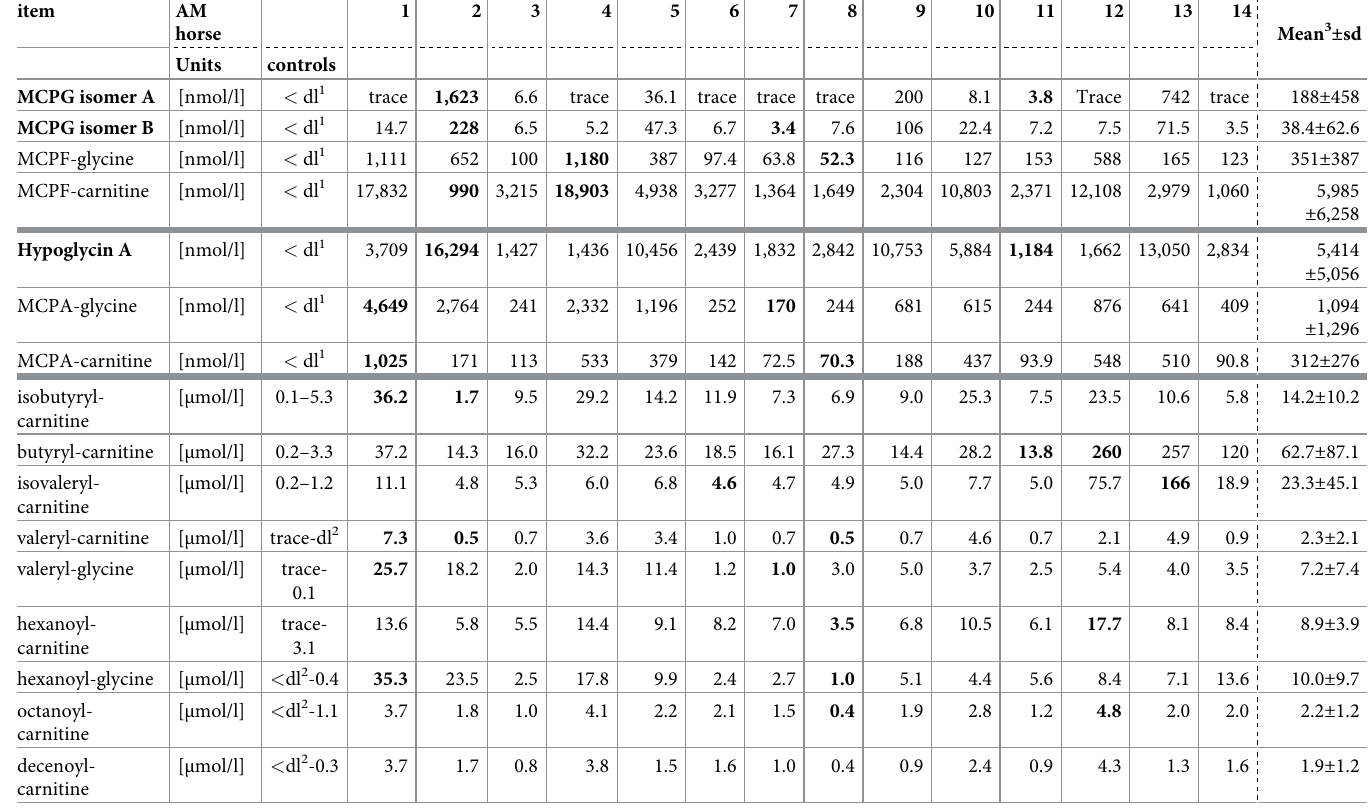
Table 3. Concentrations and means ± sd of MCPG and HGA and the corresponding metabolites in nmol/L plus the concentrations of a spectrum of acyl conjugates in μ mol/L in the serum samples of AM affected horses in comparison to the